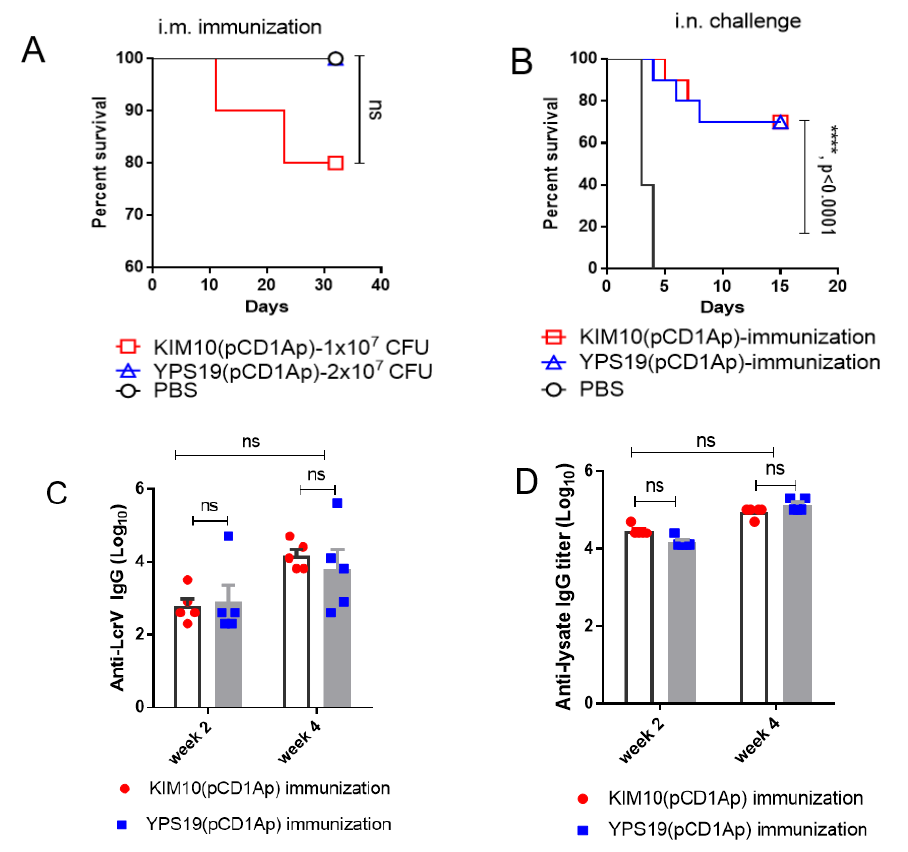
Figure 5. Mouse survival after pulmonary Y. pestis KIM6 + (pCD1Ap) challenge and serum response. Mice ( n = 10, equal males and females) were vaccinated i.m. with 1 × 10 7 CFU of KIM10(pCD1Ap), and 2 × 10 7 CFU of YPS19(pCD1Ap), respectively, and then boosted at 21 days post vaccination with corresponding strains. On day 42 after initial vaccination, the vaccinated mice were challenged i.n. with virulent Y. pestis KIM6 + (pCD1Ap). ( A ) Survival of mice after i.m. vaccination with KIM10(pCD1Ap) and YPS19(pCD1Ap), respectively. ( B ) Vaccinated Swiss Webster mice were challenged via the i.n. route with 5 × 10 3 CFU of Y. pestis KIM6 + (pCD1Ap). The log-rank (Mantel–Cox) test was used for statistical analysis, **** , the p value was less than 0.0001. ( C ) Serum IgG titers to LcrV antigen. ( D ) Serum IgG titers to Y. pestis whole cell lysate (YPL). The two-way ANOVA, ns, no